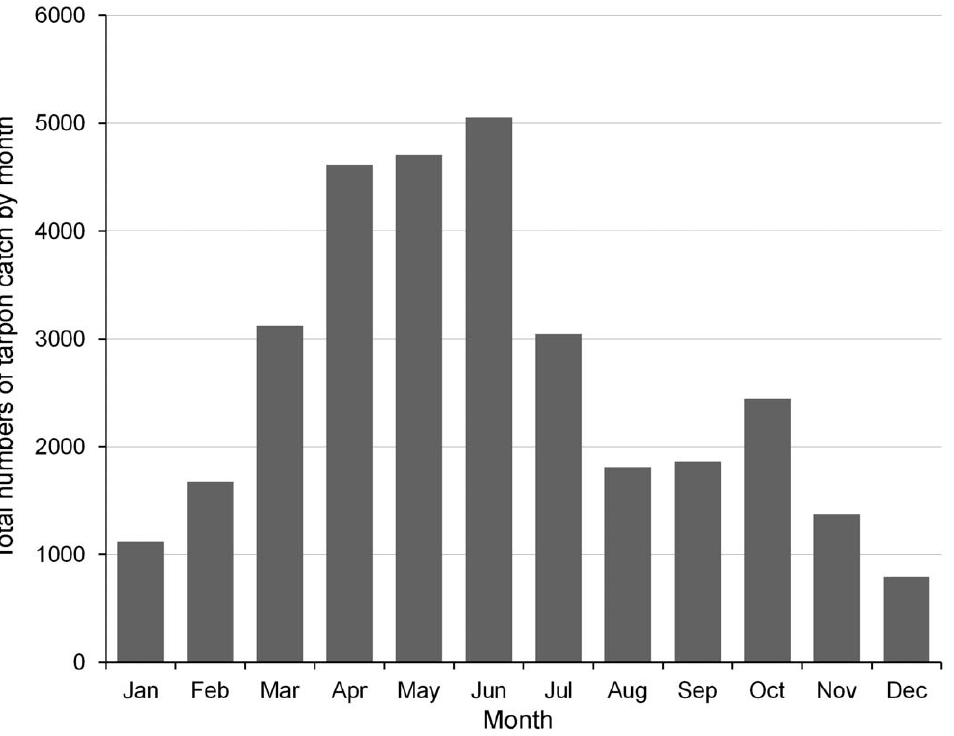
Figure 6. Average total numbers of tarpon caught by month by recreational anglers in Everglades National Park from 1980 to 2006. Data based on National Park Service Creel Surveys of professional fishing guides in Everglades National Park [36].